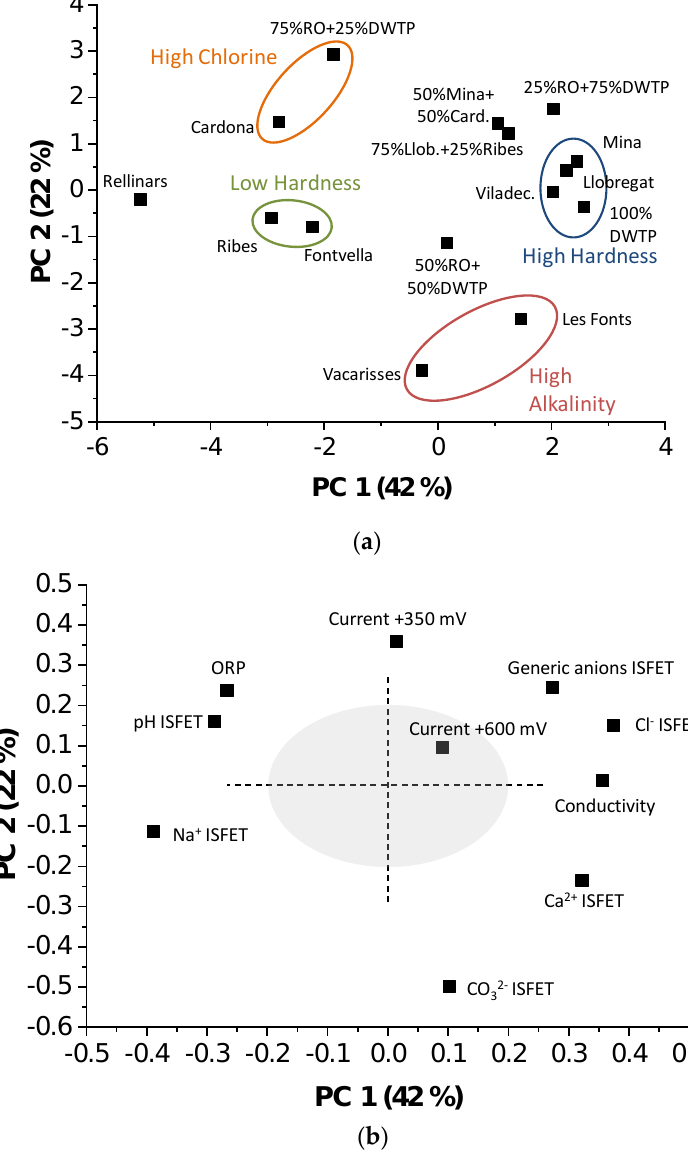
Figure 3. PCA ( a ) score plot and ( b ) loading plot obtained using the values of the variables from the electronic tongue. In the loading plot, the grey circle corresponds to the zone of low significance of the variables in the model. Llob.: Llobregat ; Card.: Cardona ; Viladec.: Viladecavalls ; RO: outlet of reverse osmosis; DWTP: outlet of drinking water treatment plant.